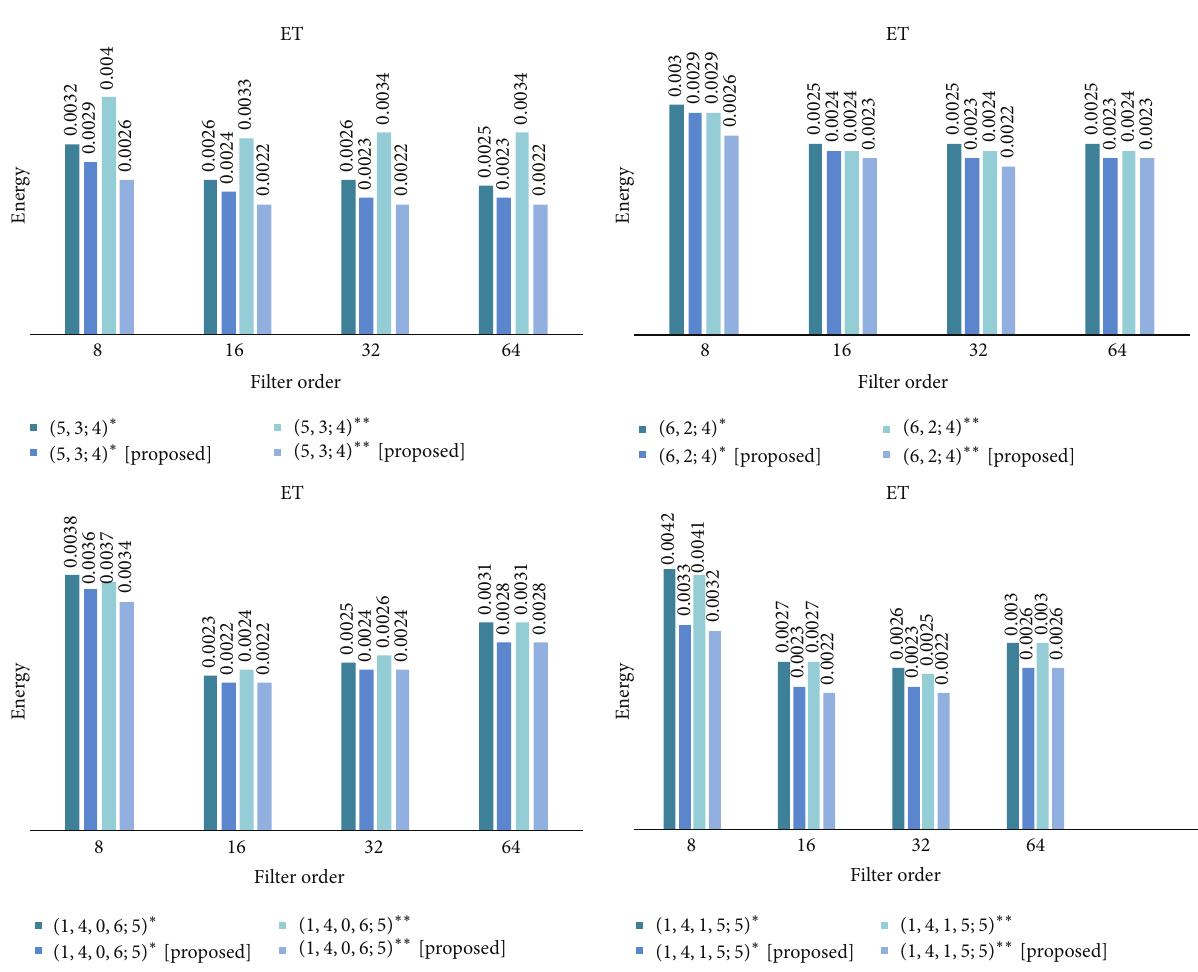
Figure 18: Energy throughput (in nJ/bit) for filters based on different GPCs on Kintex-7